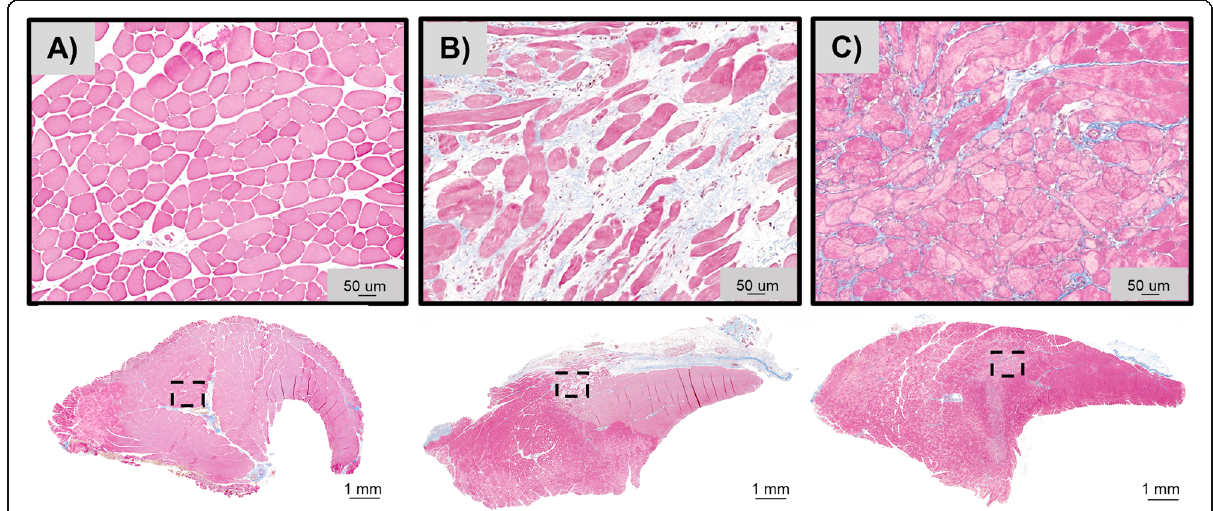
Fig. 2 Histological analysis of tibialis anterior muscle 4 weeks post-injury. Masson ’ s Trichrome staining of SHAM (A), VML injured No Repair (B), and VML injured R667 treated (C) TA muscles. Muscle, fibrous, and adipose tissues are stained red, blue, and white, respectively. Scale bars are 1 mm for whole mount images and 50 μ m for regions of